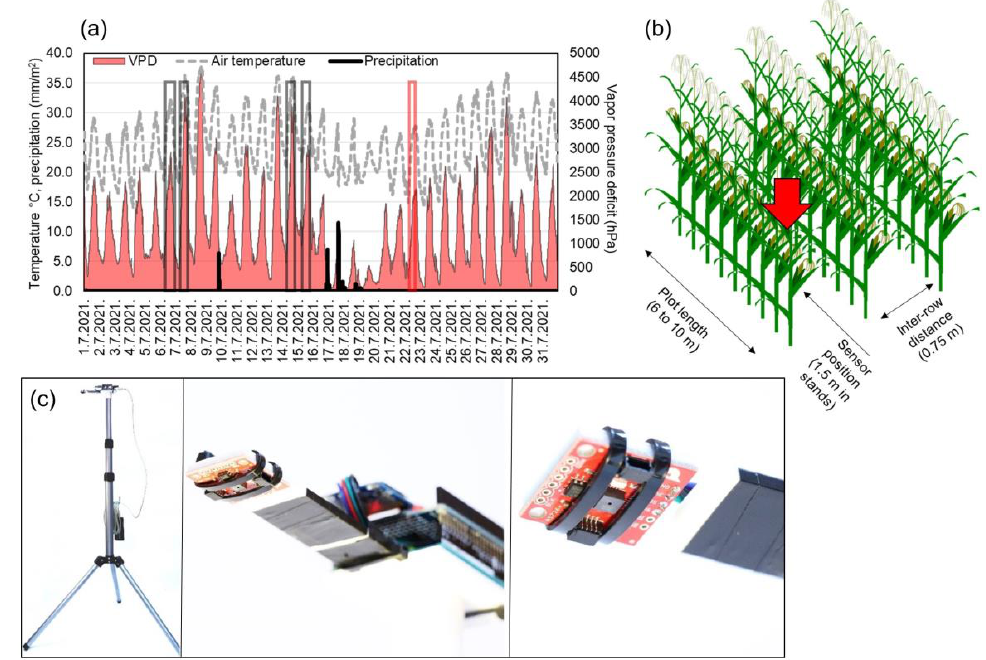
Figure 1. Schematic representation of measurement process. ( a ) shows diurnal temperatures (°C), vapor pressure deficit (hPa) and daily precipitation (mm/m 2 ) for July 2021. Gray boxes show measurement times, and the red box shows external validation set measurement time. ( b ) shows the position of tripod mounted sensor in plant stands, and ( c ) is a tripod mounted sensor wiring used to carry out the measurements. In ( c ), left image represents the tripod-mounted unit, in the middle is a close-up of wiring and a printed mount, while the right image shows AMS AS7263 sensor unit on a breakout board.